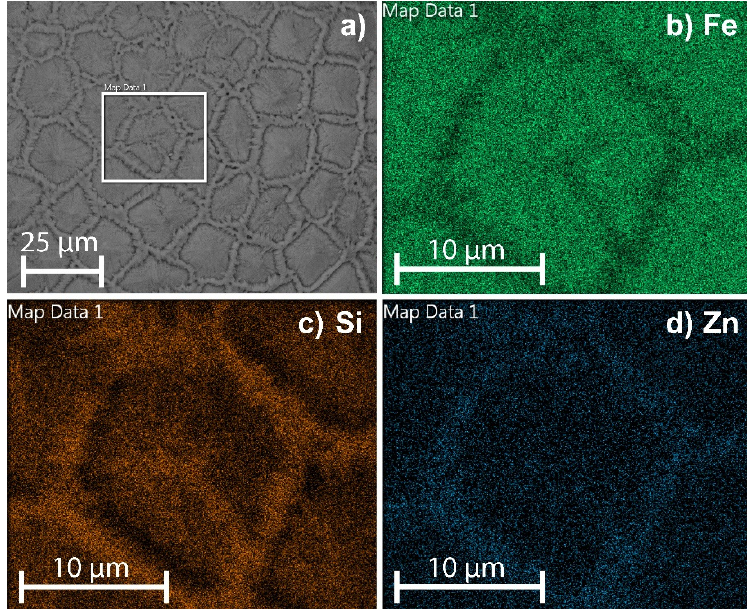
Figure 7. ( a ) SEM image and distribution of ( b ) Fe, ( c ) Si, and ( d ) Zn on sample surfaces of ZFS13-10 after static pH titration.